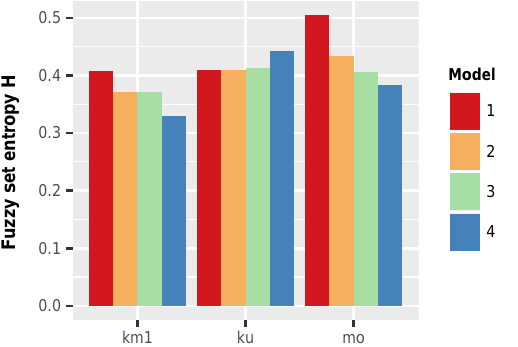
Figure 10. Fuzzy set entropy H U of the targeted geological units km1, ku and mo of the different models.